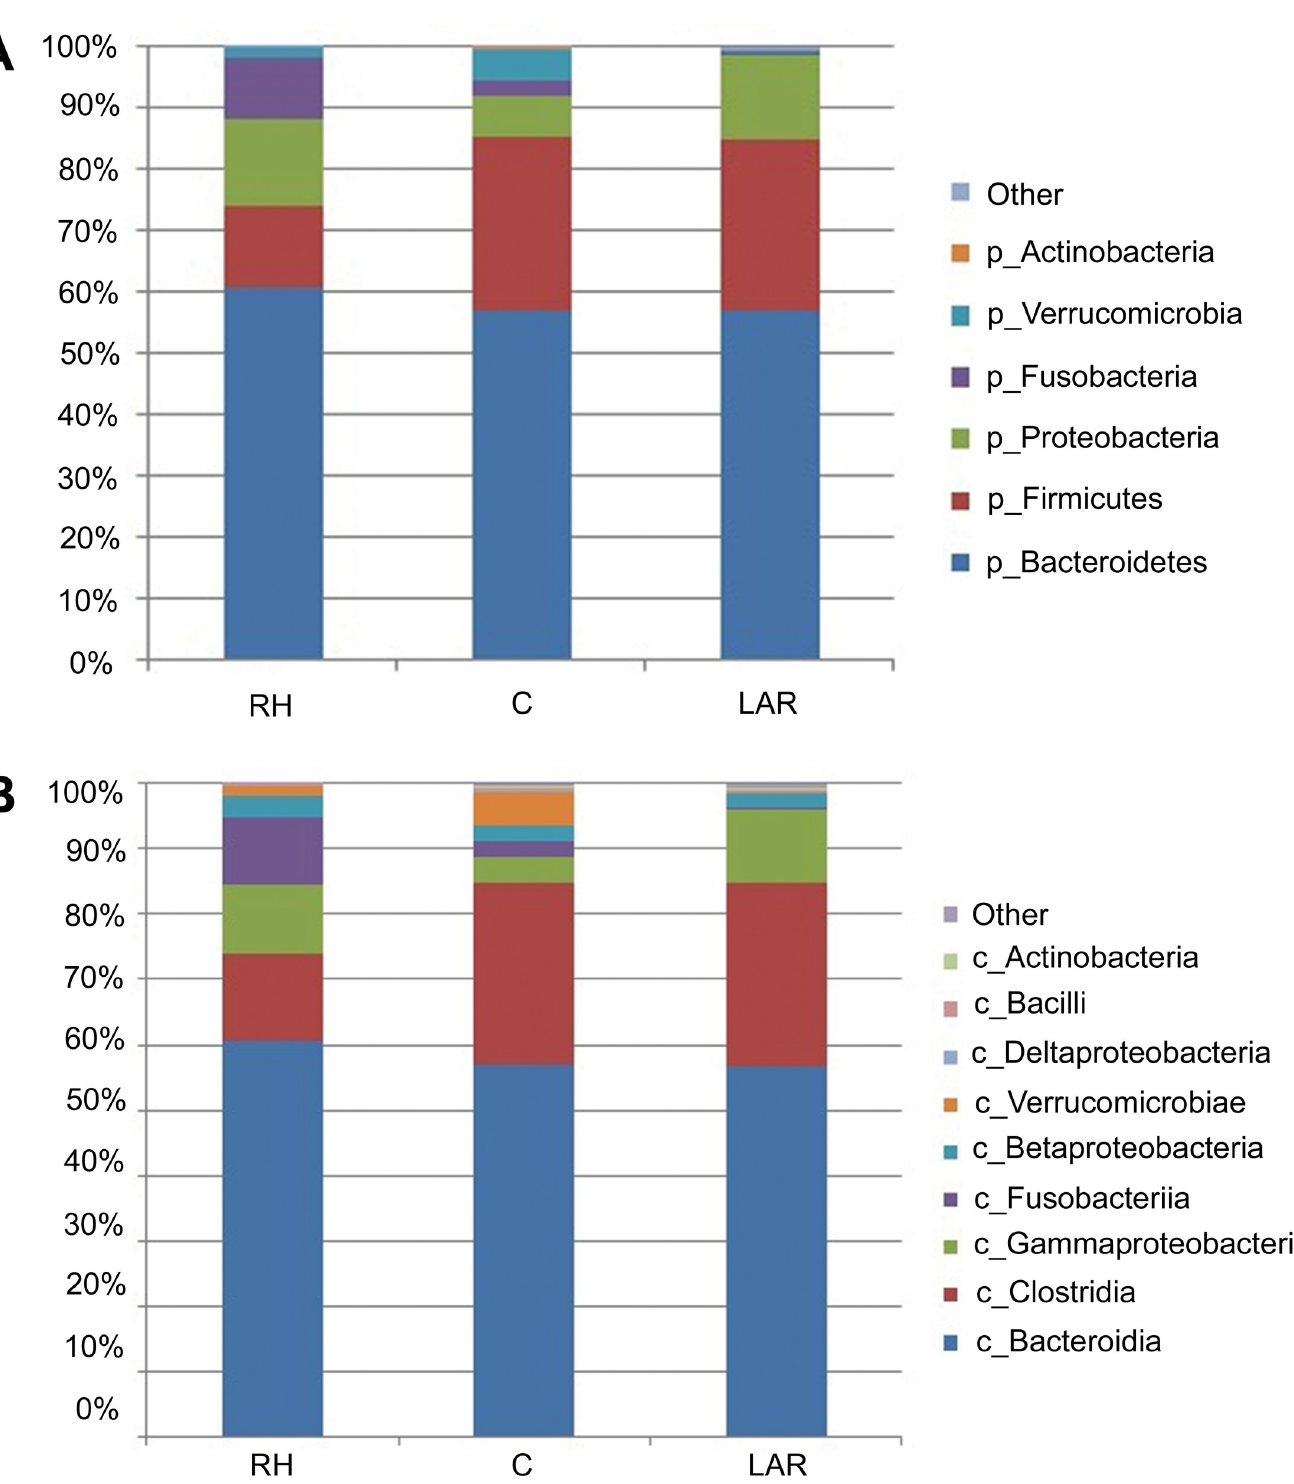
PLOS ONE | https://doi.org/10.1371/journal.pone.0218436 June 14,